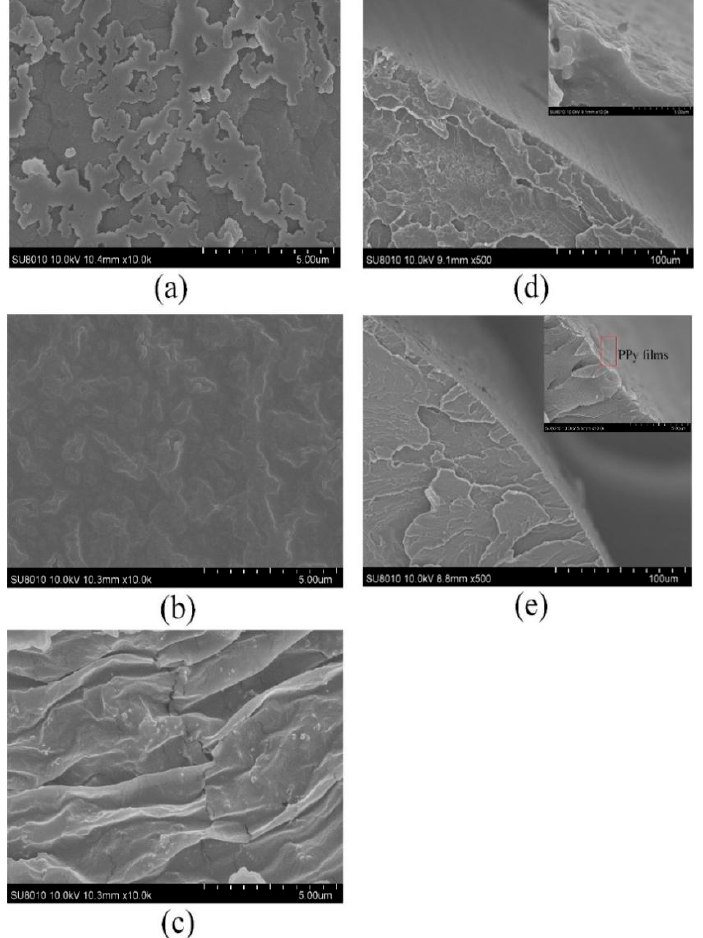
Figure 5. Micrographs of PPy films: ( a ) PPy1 (nFeCl 3 :n pyrrole = 5:1), ( b ) PPy2 (nFeCl 3 :n pyrrole = 15:2), ( c ) PPy3 (nFeCl 3 : n pyrrole = 10:1), ( d ) roughened POF taper, ( e ) roughened POF taper with PPy2 film.